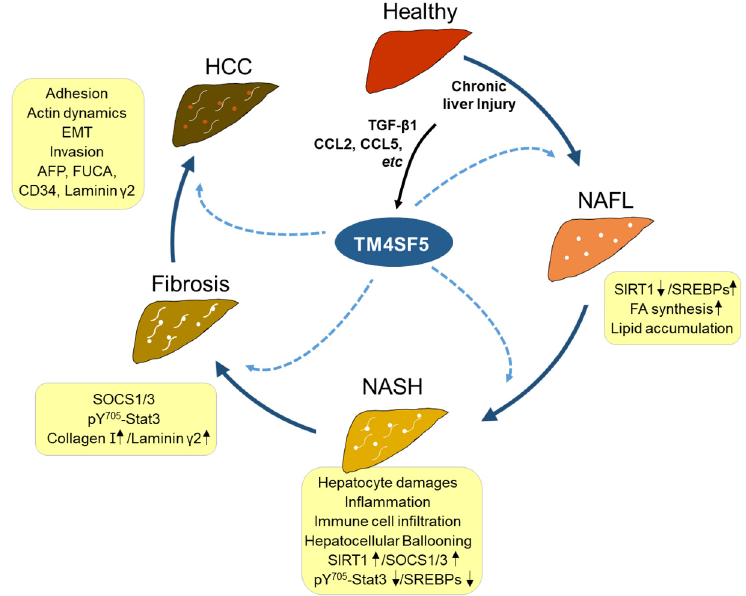
Figure 3. TM4SF5-mediated liver disease development. Healthy livers can be injured by different stimuli, including excessive nutrients, leading to lipid toxicity and hepatocyte damage. Following chronic damage, components of the inflammatory environment, including TGF β 1, CCL, CCL5, etc., can induce TM4SF5 expression in hepatocytes. Enhanced TM4SF5 can play roles in the regulation of the immunometabolic pathway and activity, consequently leading to the development of nonalcoholic steatosis (NAFL) with increased lipid uptake and accumulation, nonalcoholic steatohepatitis (NASH) with further inflammation and immune cell infiltration, fibrosis with STAT3-mediated extracellular matrix (i.e., collagen type I, laminin γ 2, etc.) deposition, and eventually, hepatocellular carcinoma (HCC) with increased expression levels of AFP ( α -fetoprotein), FUCA ( α -L-Fucosidase 1), CD34 (CD34 antigen), laminin γ 2, etc. TM4SF5-positive HCC can have features of the epithelial–mesenchymal of migration and invasion. Each dotted arrow indicates TM4SF5-mediated effects on the pathological development or progression. SOCS1/3, suppressor of cytokine signaling 1/3; STAT3, signal trans- ducer and activator of transcription 3; SIRT1, Sirtuin 1; SREBPs, sterol regulatory element binding proteins; CCL2/5, C-C motif chemokine ligand 2/5; TGF β 1, transforming growth factor β